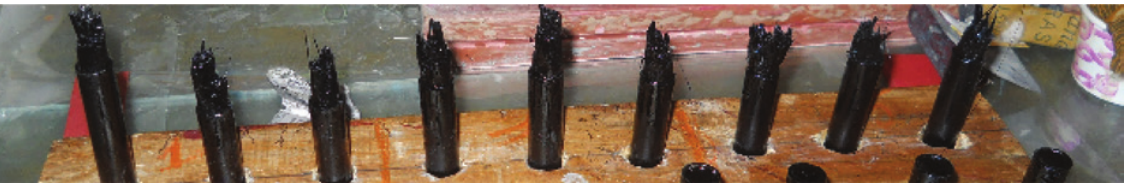
Figure 2: Strategic arrangement for the fabrication process.